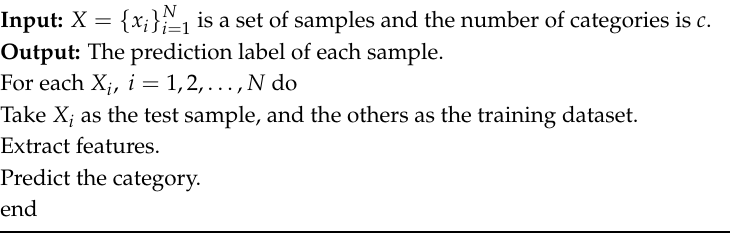
Algorithm 1: The Predictive Algorithm for piRNAPred.